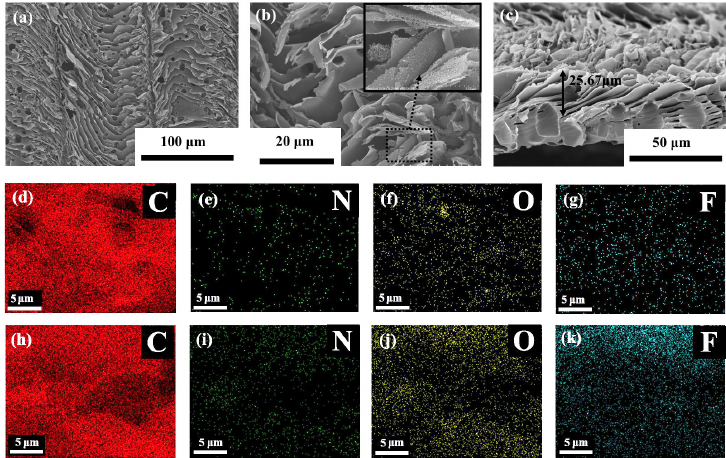
Figure 2. ( a – c ) The scanning electron microscope (SEM) images of the porous carbon materials prepared by DLW on transparent PI (DLWT)’s; ( a – b ) surface and ( c ) thickness cross-section; ( d – g ) the electron di ff raction spectroscopy (EDS) mapping of C, N, O, F of DLWT surface; ( h – k ) the EDS mapping of C, N, O, F of thickness